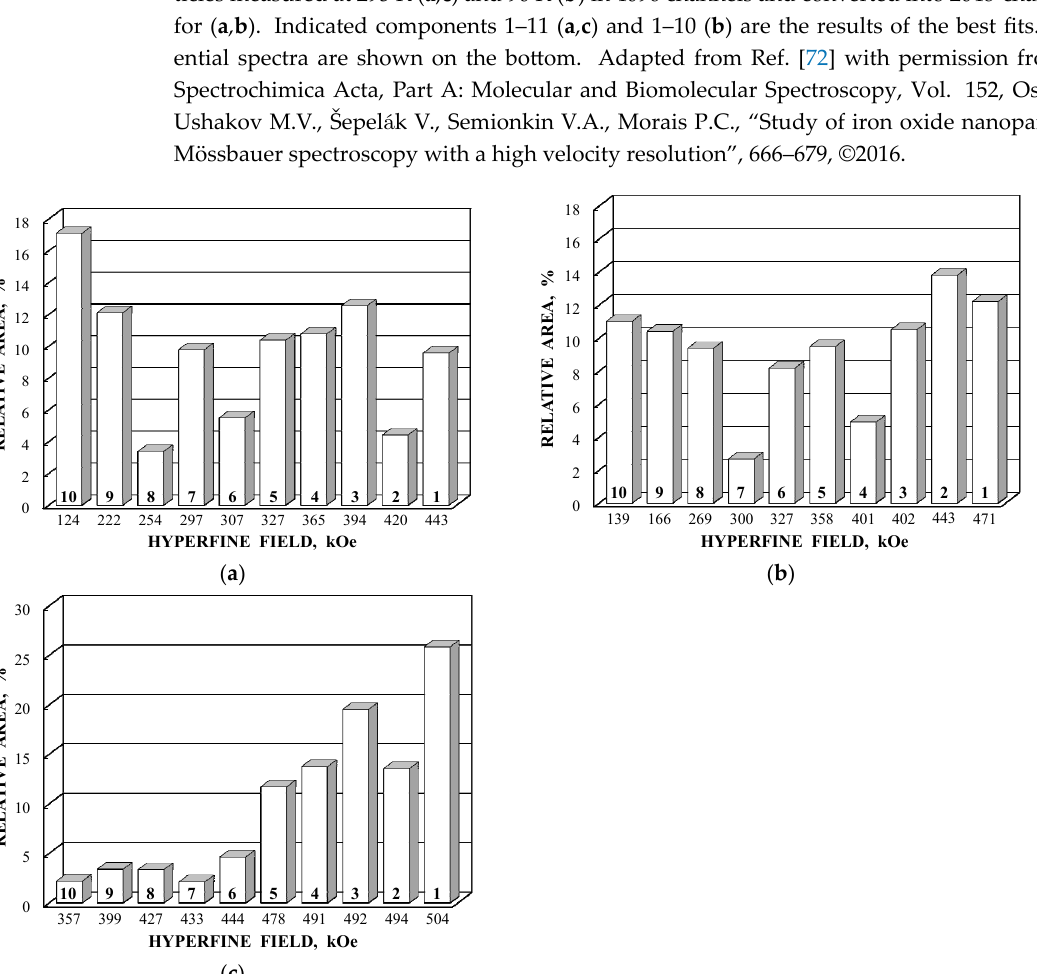
Figure 39. Histograms of the distributions of the relative areas of magnetic sextets in the order of increase in the H eff values for corresponding spectral components of the γ‐ Fe 2 O 3 /Fe 3 O 4 –IMF ( a , b ) and γ‐ Fe 2 O 3 /Fe 3 O 4 –OAT ( c ) nanoparticles measured at 295 K ( a , c ) and 90 K ( b ) (the numbers of sextets are the same as indicated in Figure 38). Adapted from Ref. [72] with permission from Else ‐ vier: Spectrochimica Acta, Part A: Molecular and Biomolecular Spectroscopy, Vol. 152, Oshtrakh